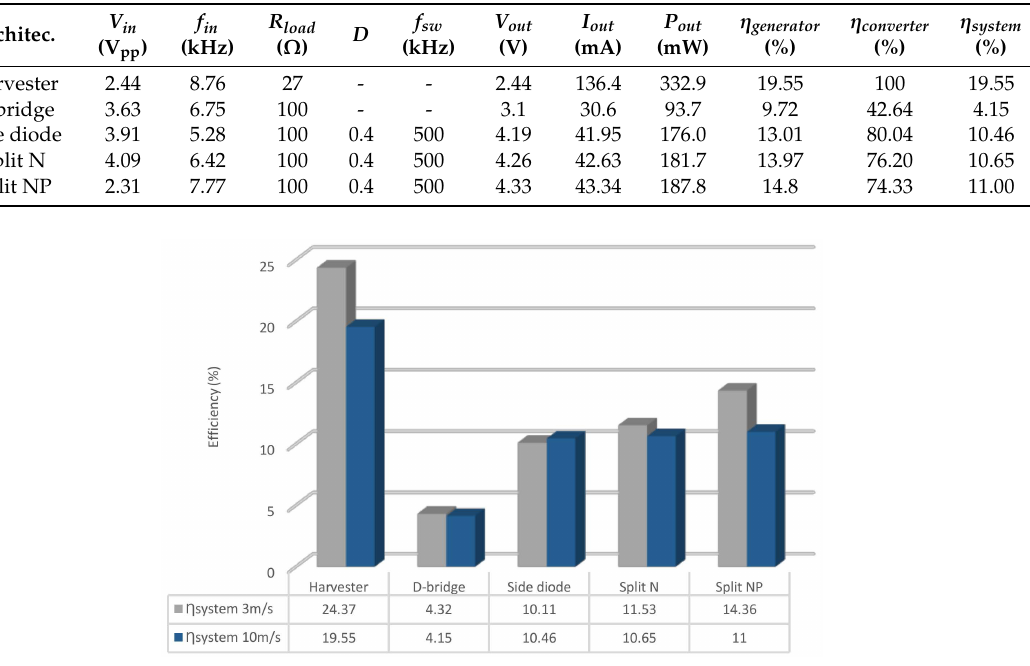
Figure 35. System e ffi ciencies with di ff erent